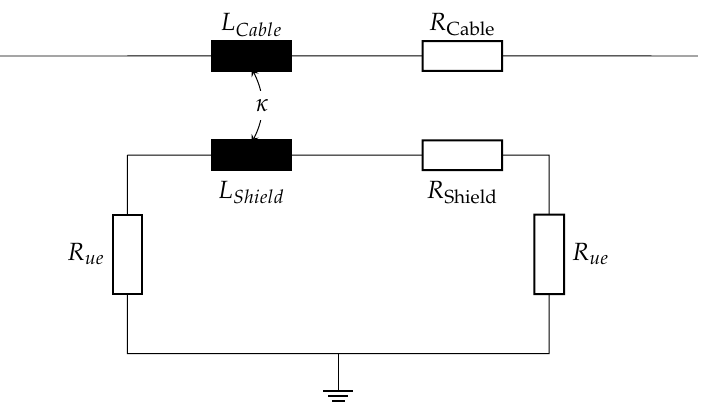
Figure 5. Modelling of one individually shielded HV cable where both ends of the shielding are connected to the vehicle ground (GND). The resistor R ue represents the connecting resistance, which is a design value in the system requirement sheet. κ is the coupling factor between the shield and the cable core. The resistance and inductivity of the cables ( L cable and R cable ) are discussed in Figure